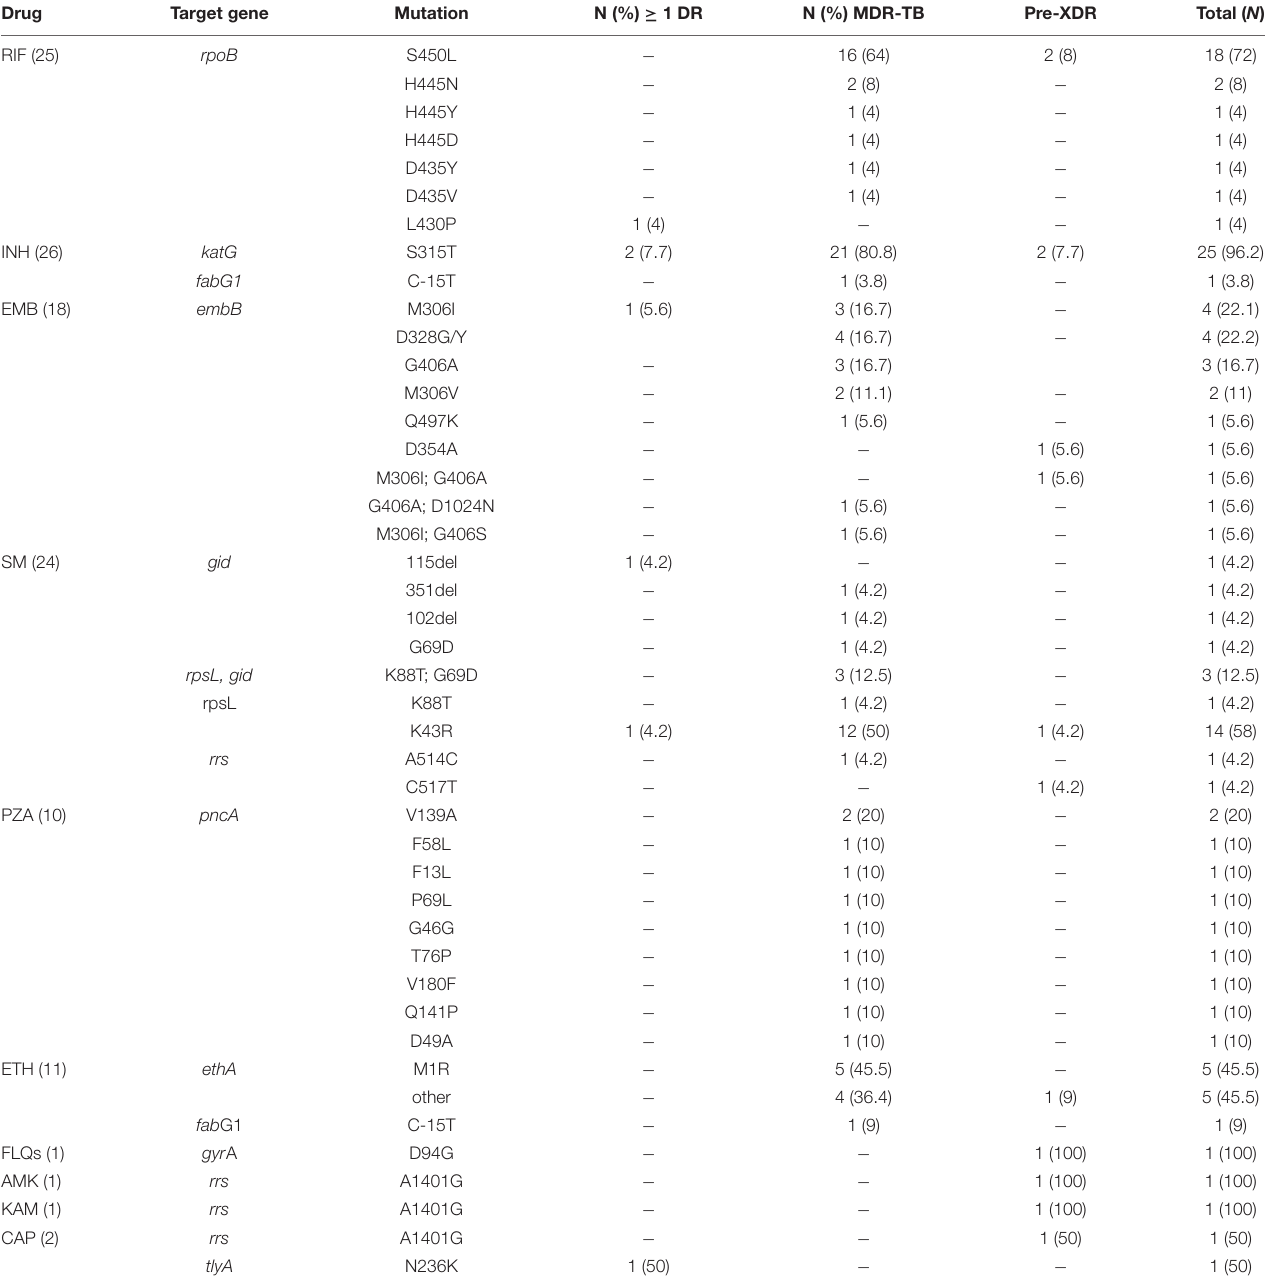
TABLE 3 | Frequency of gene mutation for 1st-and 2nd-line anti-TB drugs. Drug Target